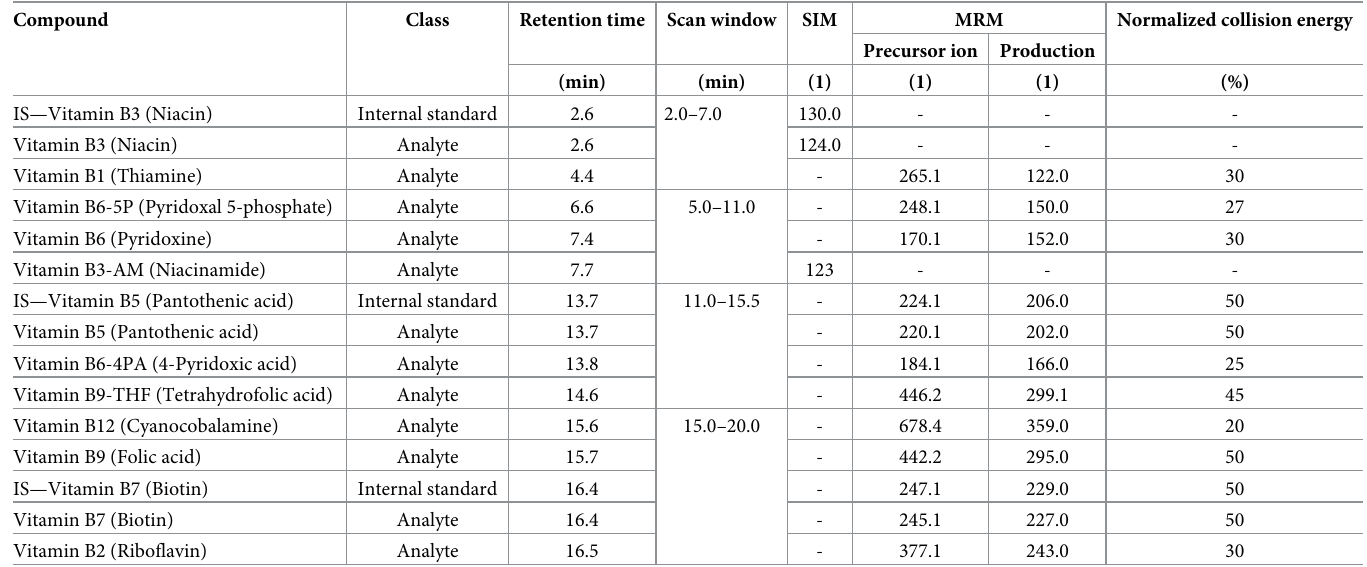
Table 1. Optimal detection conditions.